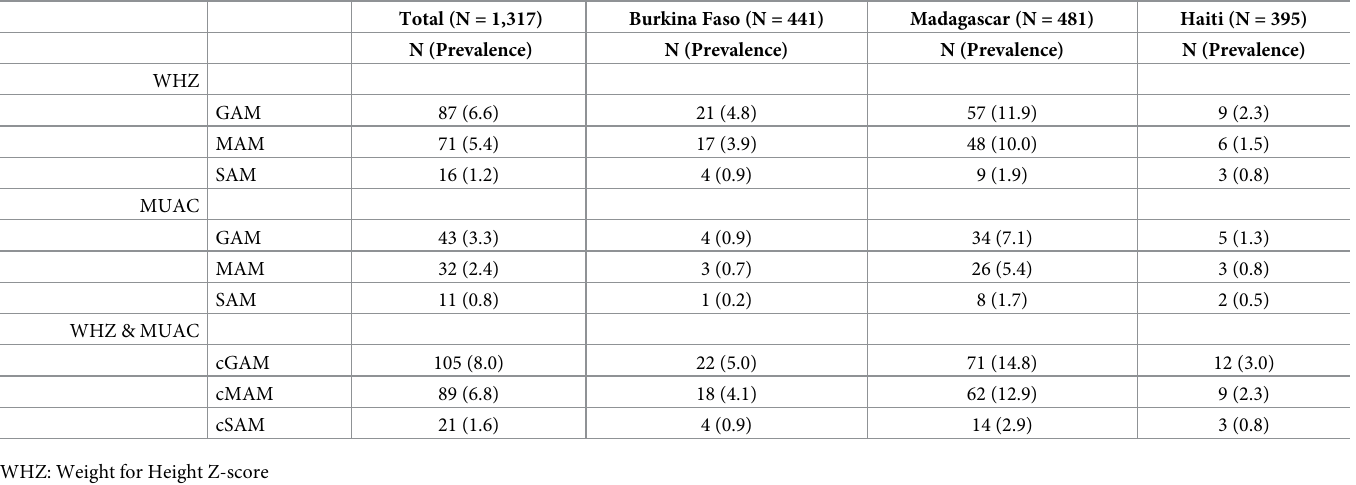
Table 3. Prevalence of acute malnutrition in the study